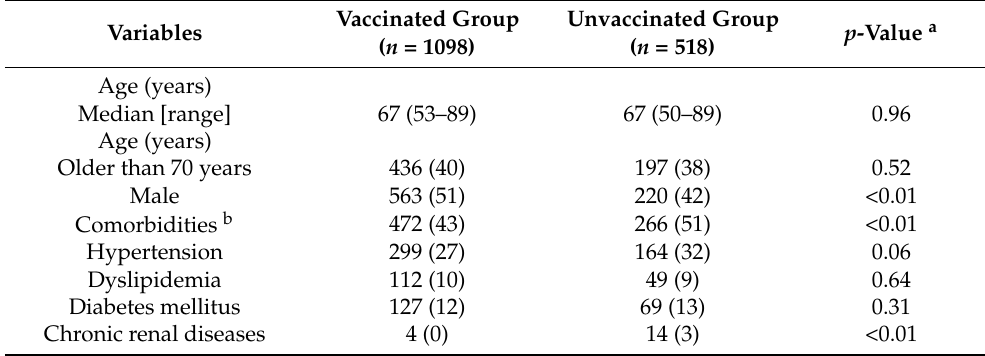
Table 1. Characteristics of the study